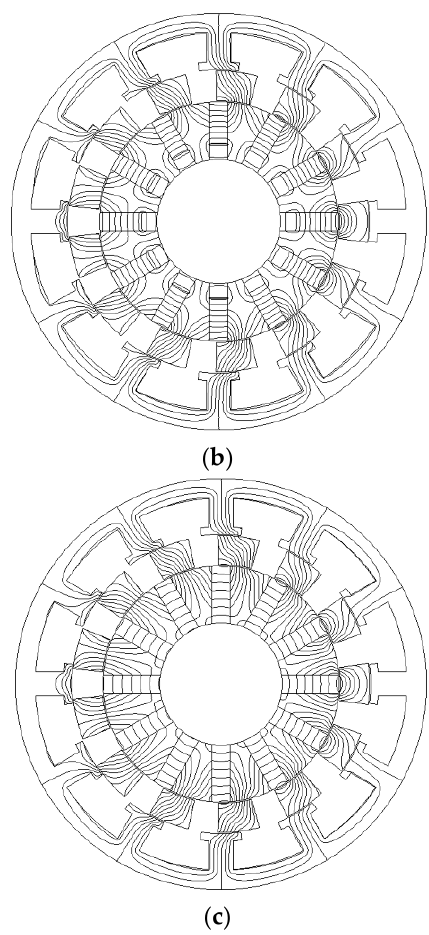
Figure 5. Magnetic flux distributions: ( a ) PS-SFPM; ( b ) FA-PS-SFPM; ( c ) PS-SFDE.